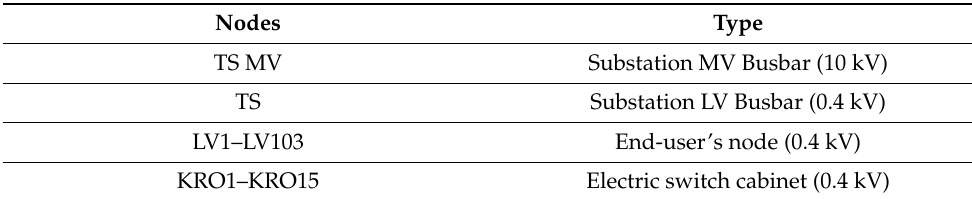
Table 2. Nodes in the observed network.